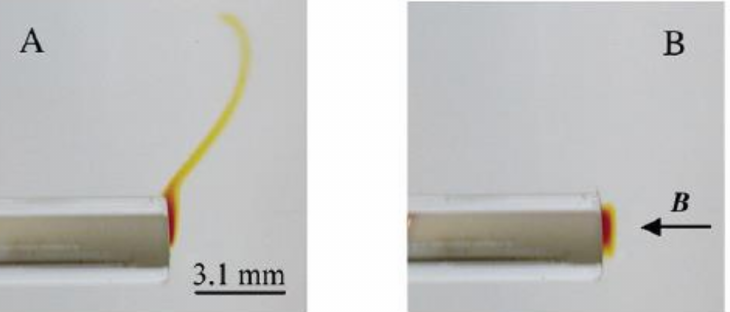
Figure 6. Photos of the horizontal orientated cylinder electrode in the nitrobenzene (NB) solu- tion with ( B ) and without ( A ) exposure of the magnetic field. The direction of the magnetic field is indicated [31].